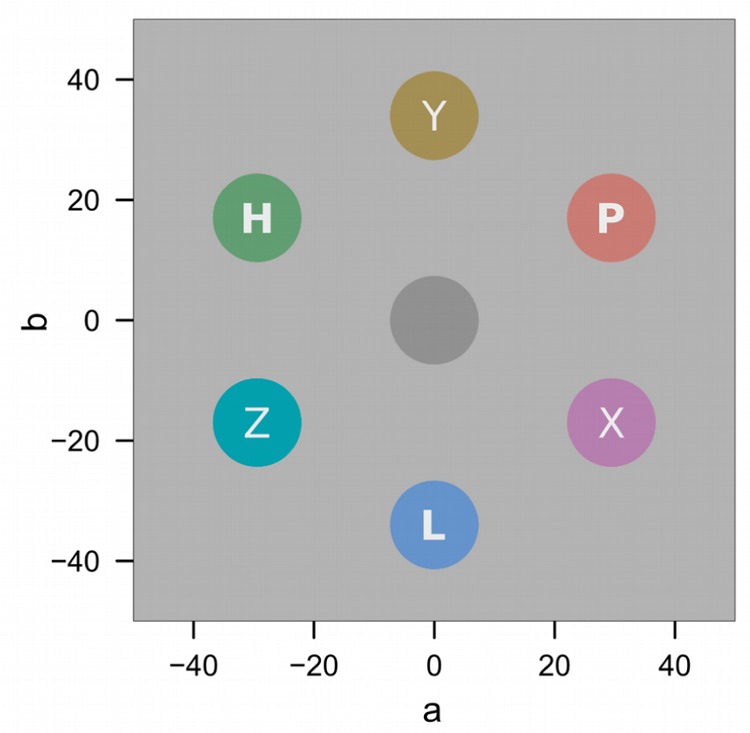
Stimulus colors in CIE L∗a∗b space. Letters L, P, H illustrate assignment of colors to the low, partial, and high expectancy conditions. Letters X, Y, Z illustrate assignment of colors to the diamond distracters.